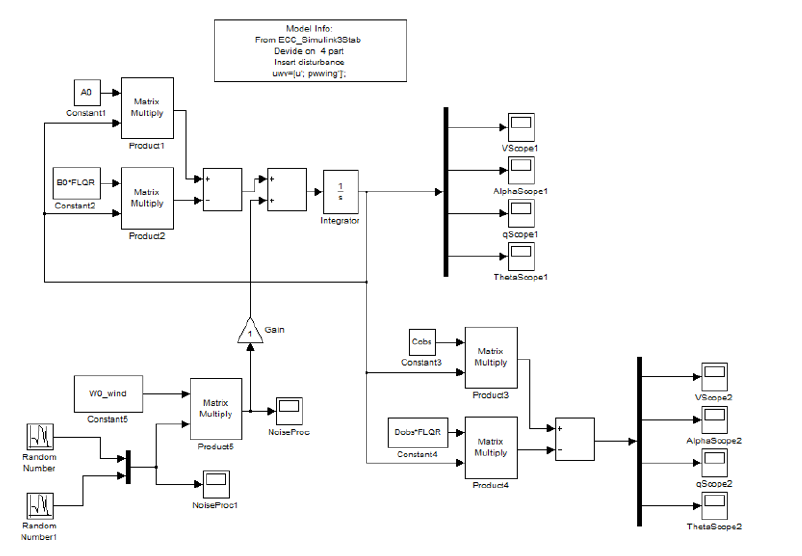
Fig. 2 . Disturbance model of a stabilization system in